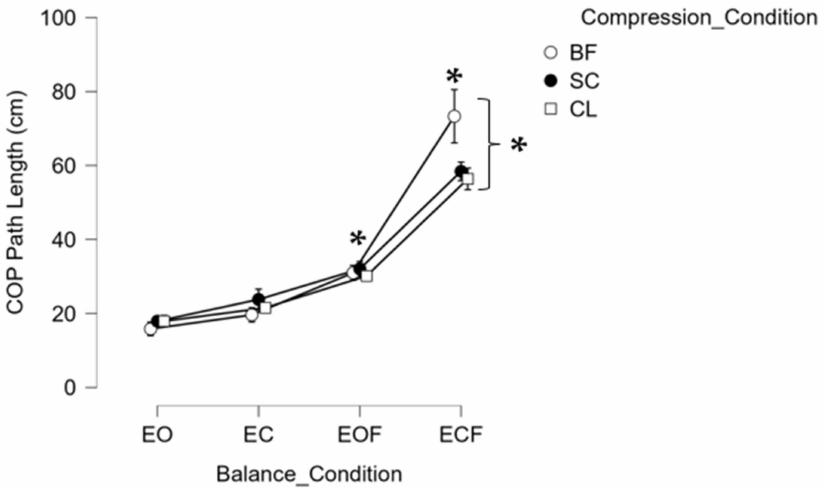
Figure 2. Center of Pressure (COP) path length (cm) during the modified clinical test of sensory integration of balance (mCTSIB) conditions: eyes open (EO), eyes closed (EC), eyes open foam (EOF), and eyes closed foam (ECF) in three compression conditions: barefoot (BF), sub-clinical compression sock (SC), and clinical compression sock (CL). * represents significant differences, and bars represent standard